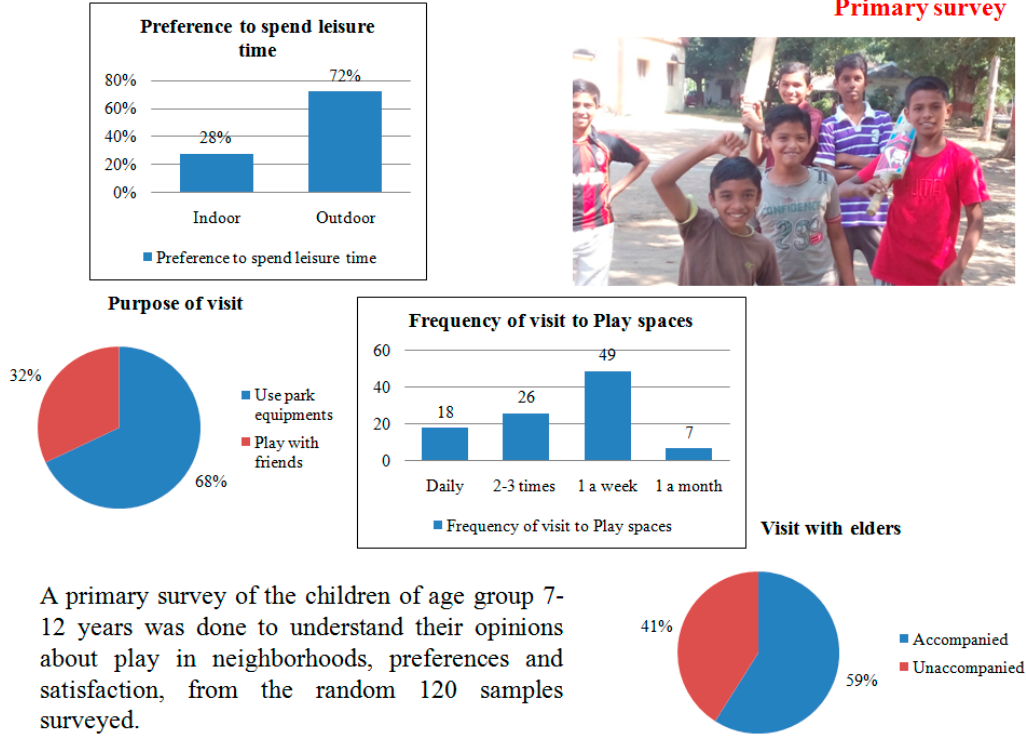
Figure 4. Children’s satisfaction with existing play provisions in their neighborhoods.